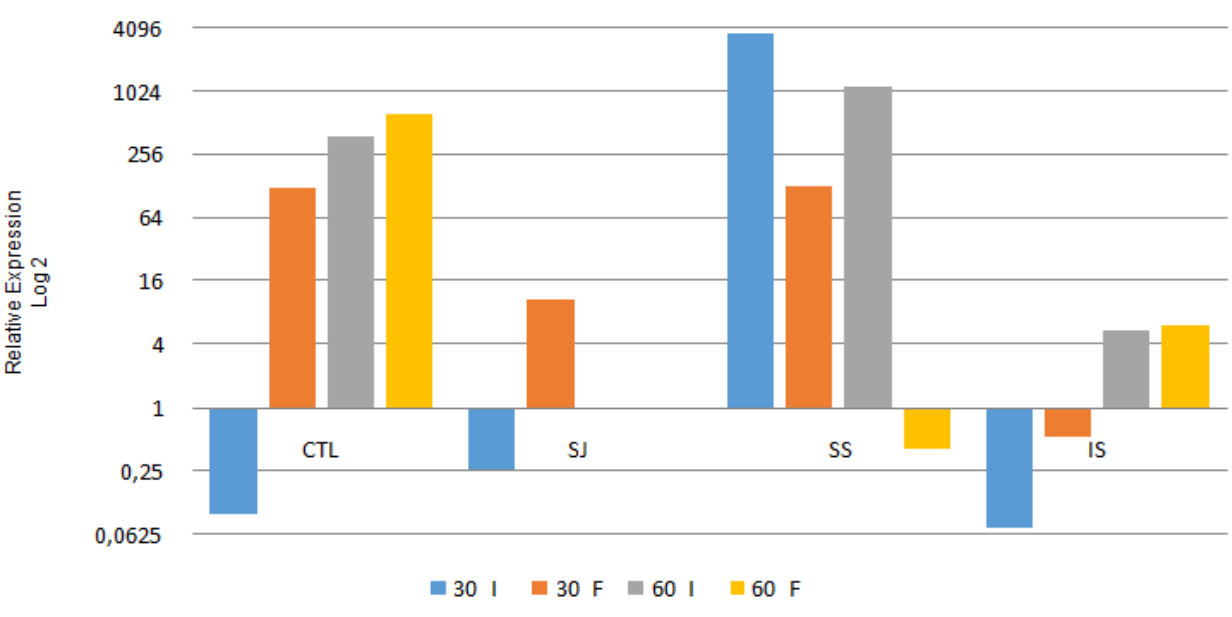
Figure 1. Relative expression of the vitellogenin gene in intern bees (I) and forager bees (F) under the different treatments used after 30 days and 60 days. CTL: control; SJ: sugarcane juice; SS: sugar syrup; IS: inverted sucrose. 60 I and 60 F: Data not obtained due to death of the colonies during the experimental